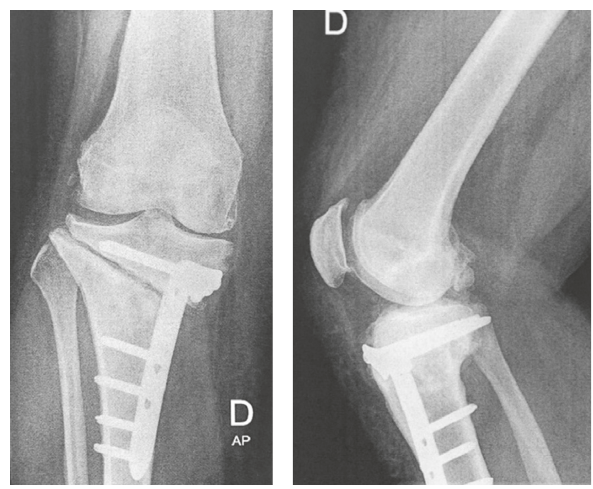
Figure 7: June 2012, 2 years after revision, postoperative X-rays showing medial gonarthritis.